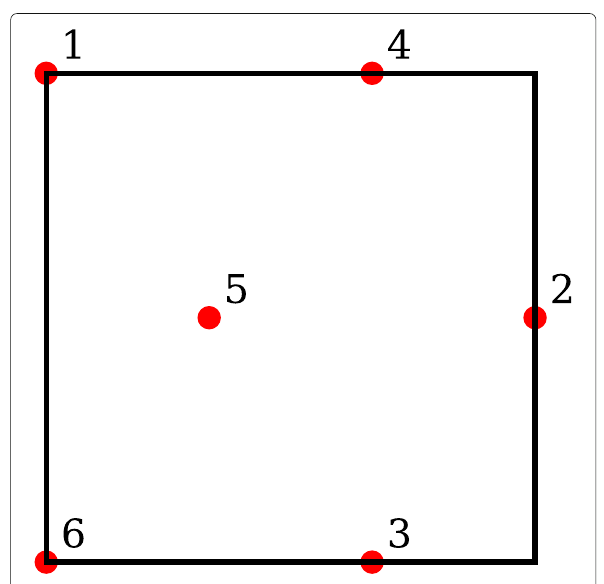
Fig. 5 The solution to the 6-dispersion problem in a square area we can constrain, without losing optimality, the EPC( X ) and Cluster( X ) models by fixing the assignment of these points to different circles and clusters, respectively. Identi- fying such a subset is a combinatorial problem, formulated as follows.